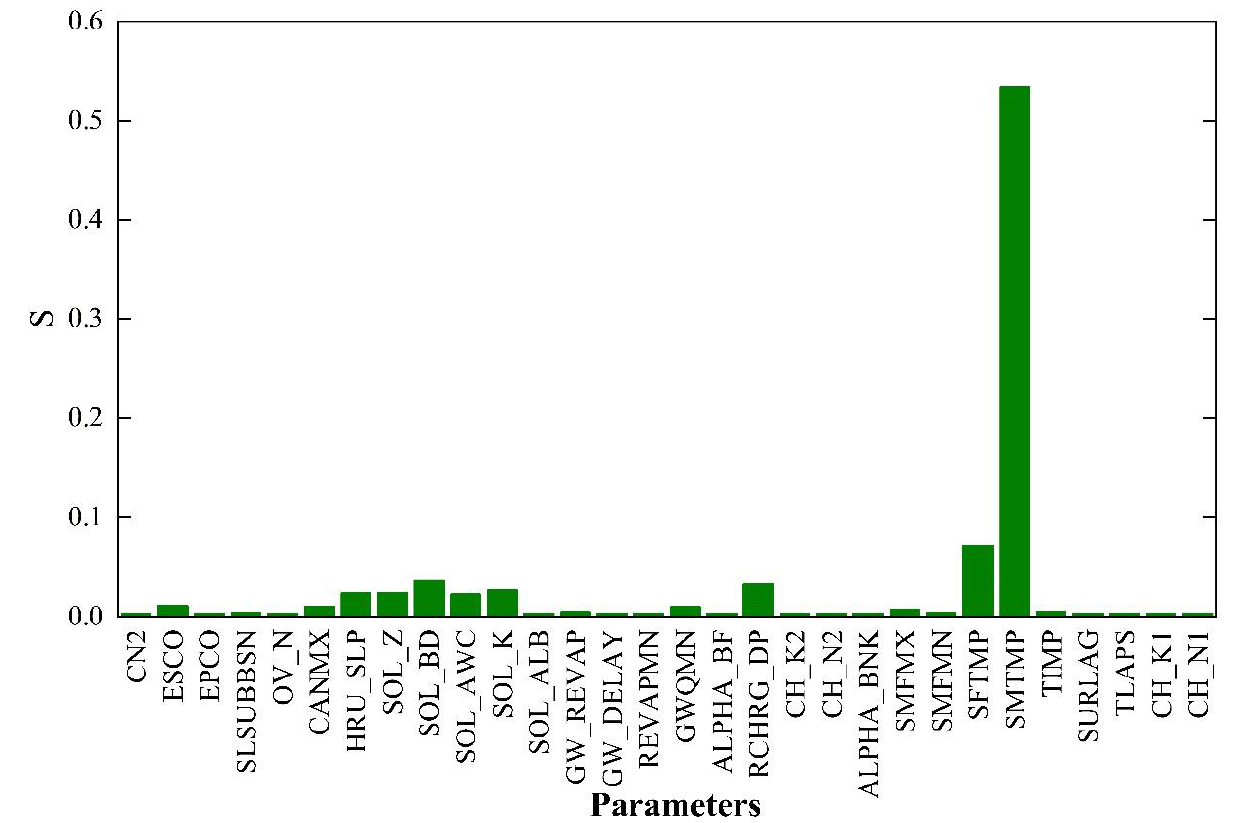
Figure 11. First-order sensitivity ( S ) of each parameter of EFAST.